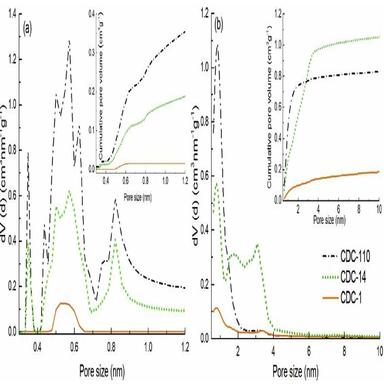
Differential and cumulative (as insets) pore size distribution diagrams of CDC-1 (orange), CDC-14 (green) and CDC-110 (black) according to CO2 adsorption (a) and N2 adsorption (b). (A colour version of this figure can be viewed online.)